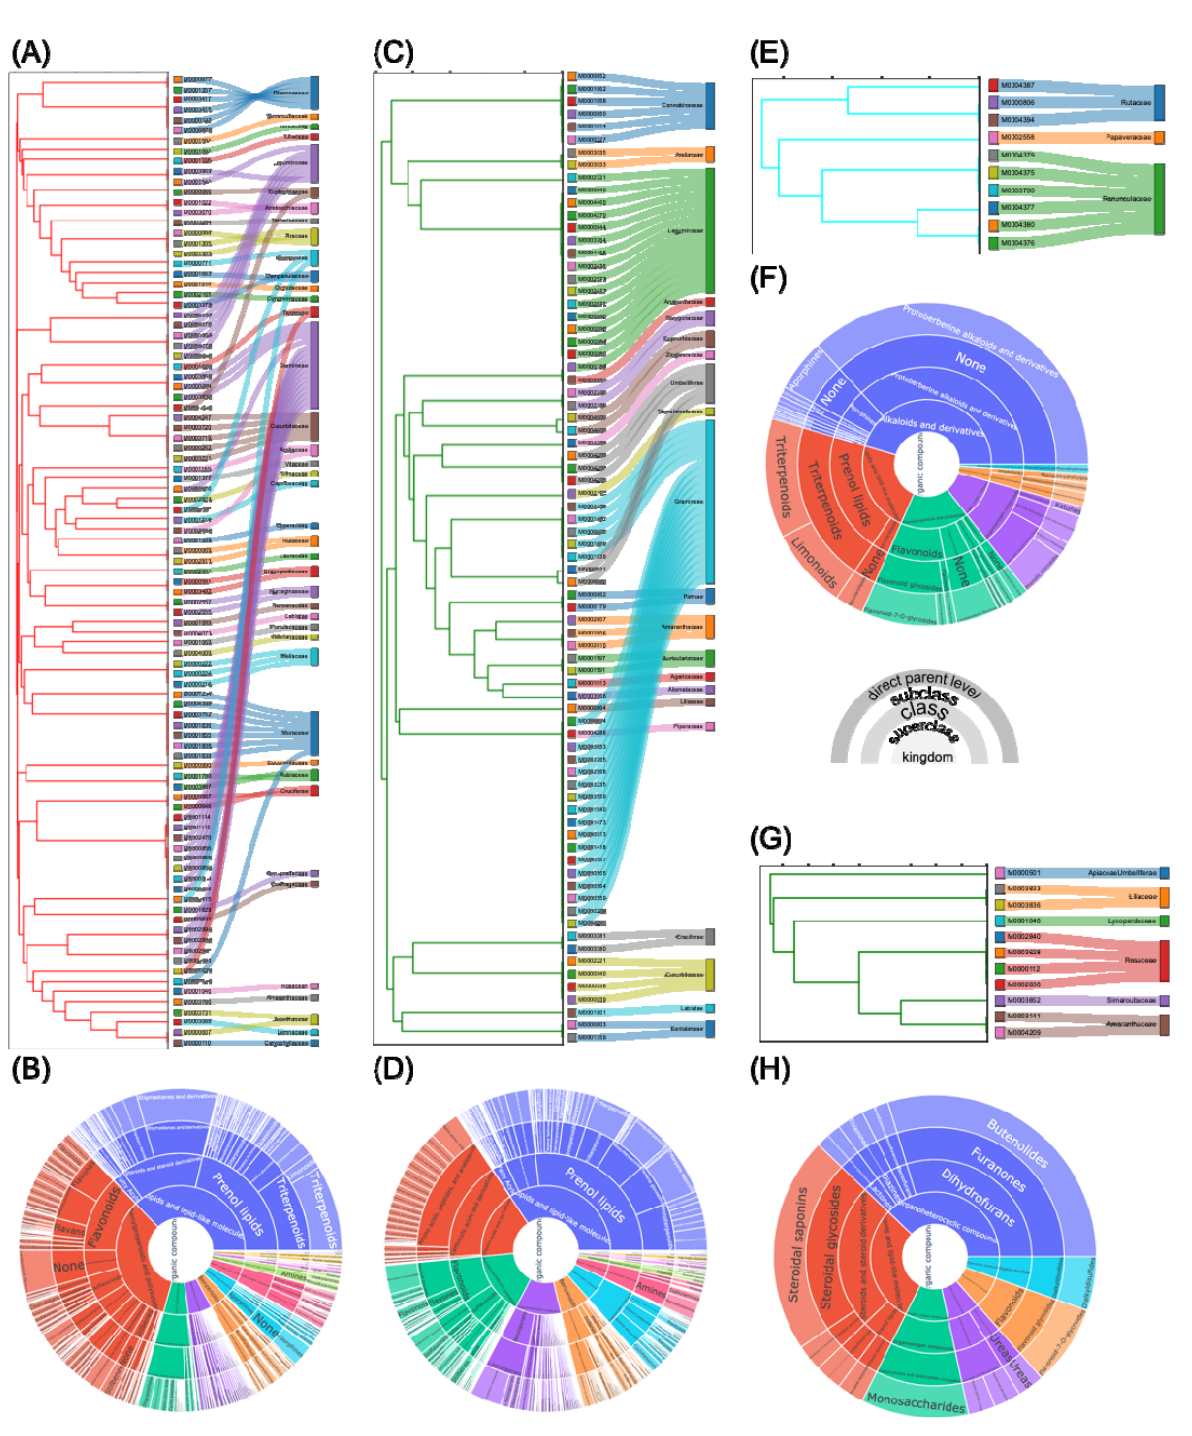
Figure 2. The four sub-clusters in the whole dendrogram (Figure S2). ( A ) The largest sub-cluster in the whole network. ( B ) The classification of chemicals in ( A ). ( C ) The second largest sub-cluster in the whole network. ( D ) The classification of chemicals in ( C ). ( E ) The sub-cluster of the nodes sharing protoberberine-type chemicals in the whole network. ( F ) The classification of chemicals in ( E ). ( G ) The sub-cluster of the nodes sharing vitamins in the whole network. ( H ) The classification of chemicals in ( G ).